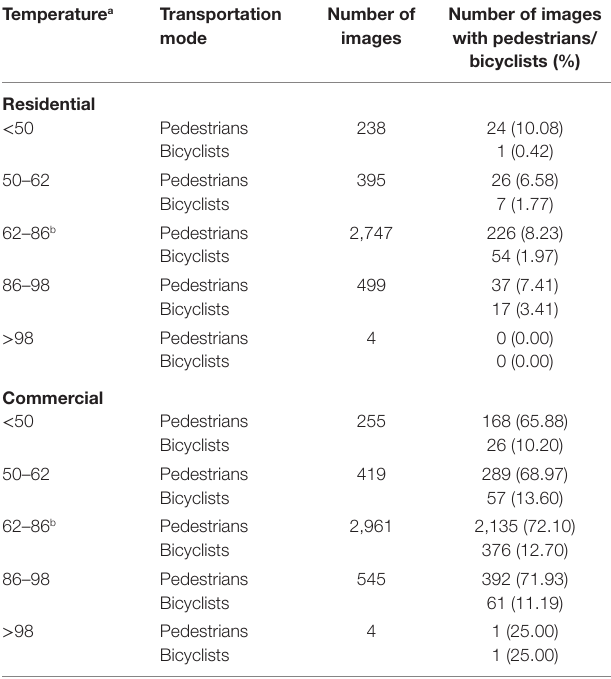
TaBle 2 | Pedestrian and bicyclist presence at various temperatures, by intersection.